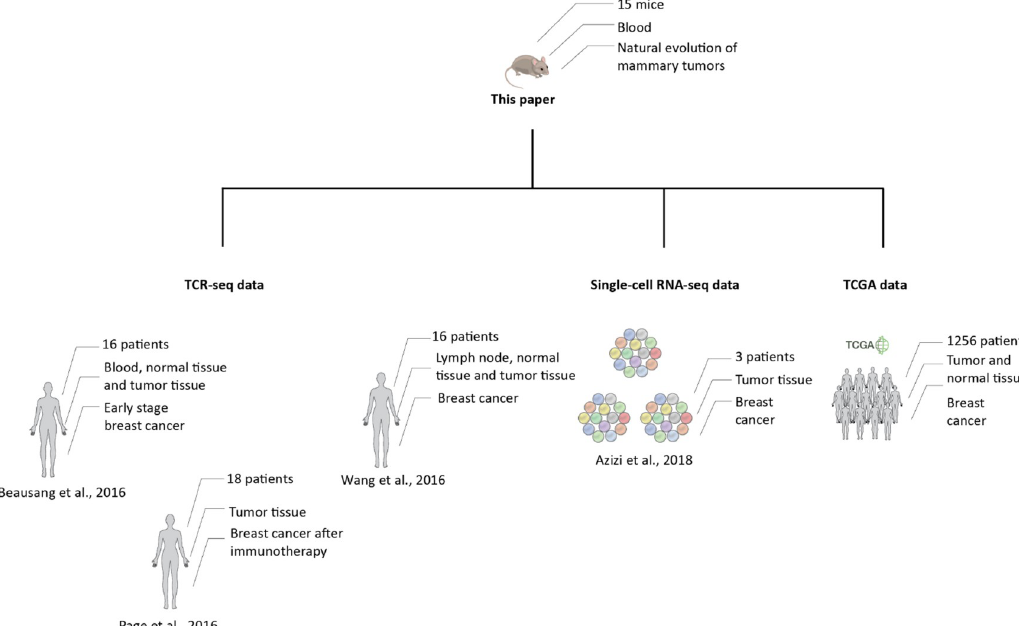
Fig 3. Comparing human T cell repertoire data and mouse T cell repertoire data. To learn more about the connection between the repertoires of mouse mammary tumor and human breast cancer, we studied the three different types of datasets (left to right): (1) TCR β -seq data from 50 breast cancer patients from 3 different studies, in which different conditions and different tissues were studied. (2) Single-cell RNA-seq TCR data of 3 breast cancer patients obtained from Azizi et al. (3) TCR sequences extracted from RNA-seq data of breast cancer patients obtained from The Cancer Genome Atlas